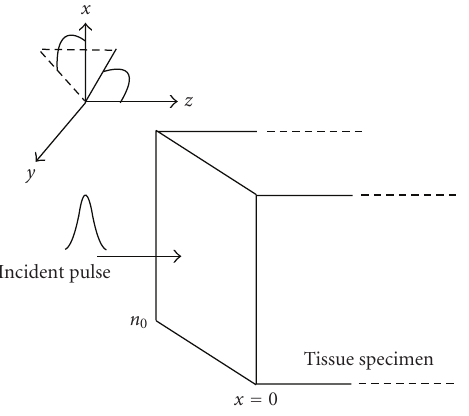
Figure 2: Light pulse incident on a tissue